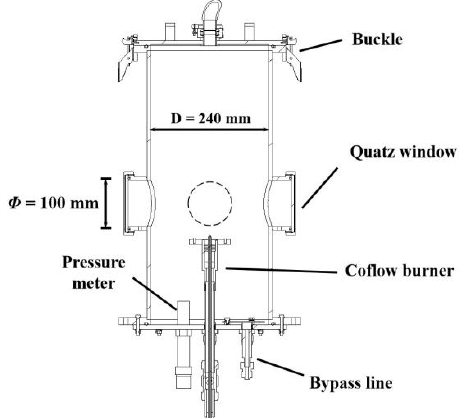
Figure 2. A schematic of the low-pressure combustion chamber.